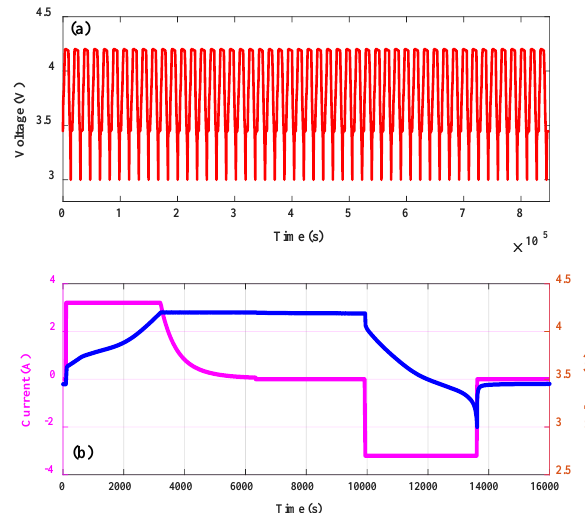
Figure 2. Profiles obtained in the cycling test: ( a ) entire voltage profile and ( b ) voltage and current profile at one cycle.